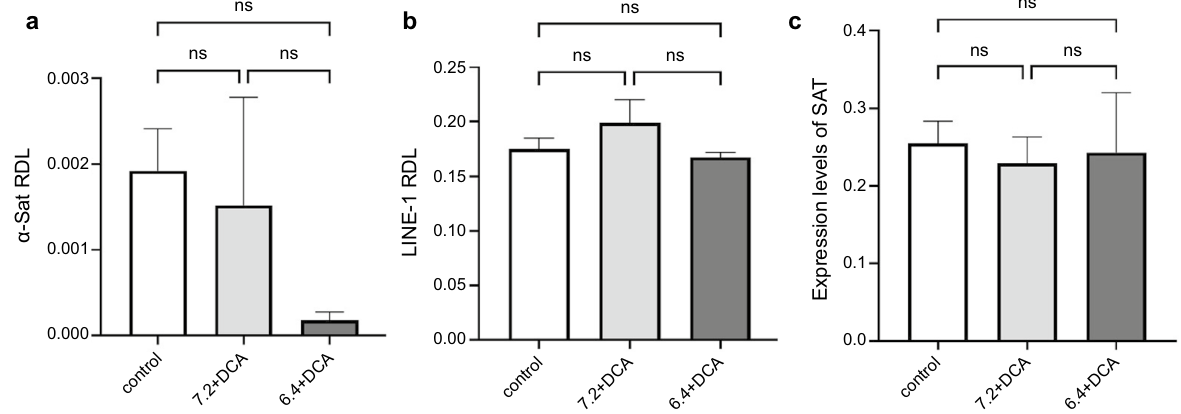
Figure 2. Relative hypomethylation levels of alpha satellite and LINE-1 repetitive sequences and expression levels of satellite alpha transcripts when exposed to acid and deoxycholic acid in OACP4C cells. To assess the relative hypomethylation levels, the relative demethylation levels (RDL) of alpha satellite (α-Sat) and LINE-1 repetitive sequences were determined. The expression of satellite alpha transcripts (SAT) was also calculated. There was no significant difference in α-Sat, LINE-1 RDL and expression levels of SAT under several conditions of acid deoxycholic acid in OACP4C cells, respectively. ns ; no significance.